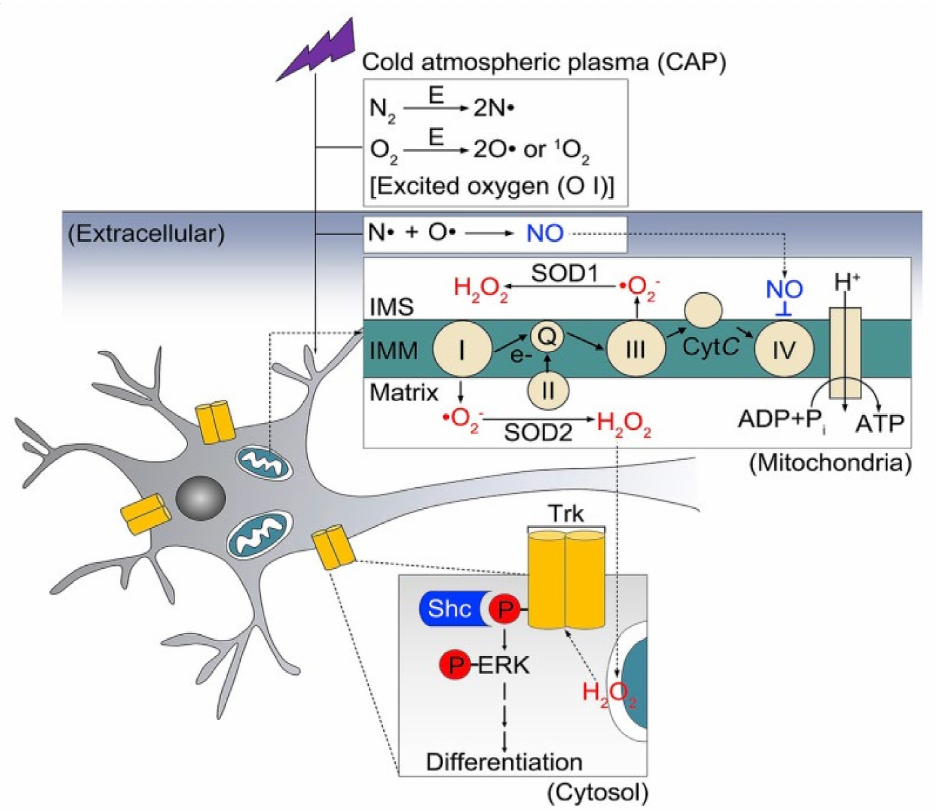
Figure 4. CAP-based mechanism for neuron stimulation di ff erentiation by Trk / Ras / ERK signaling pathway [154]. IMS, intermembrane space; IMM, inner mitochondrial